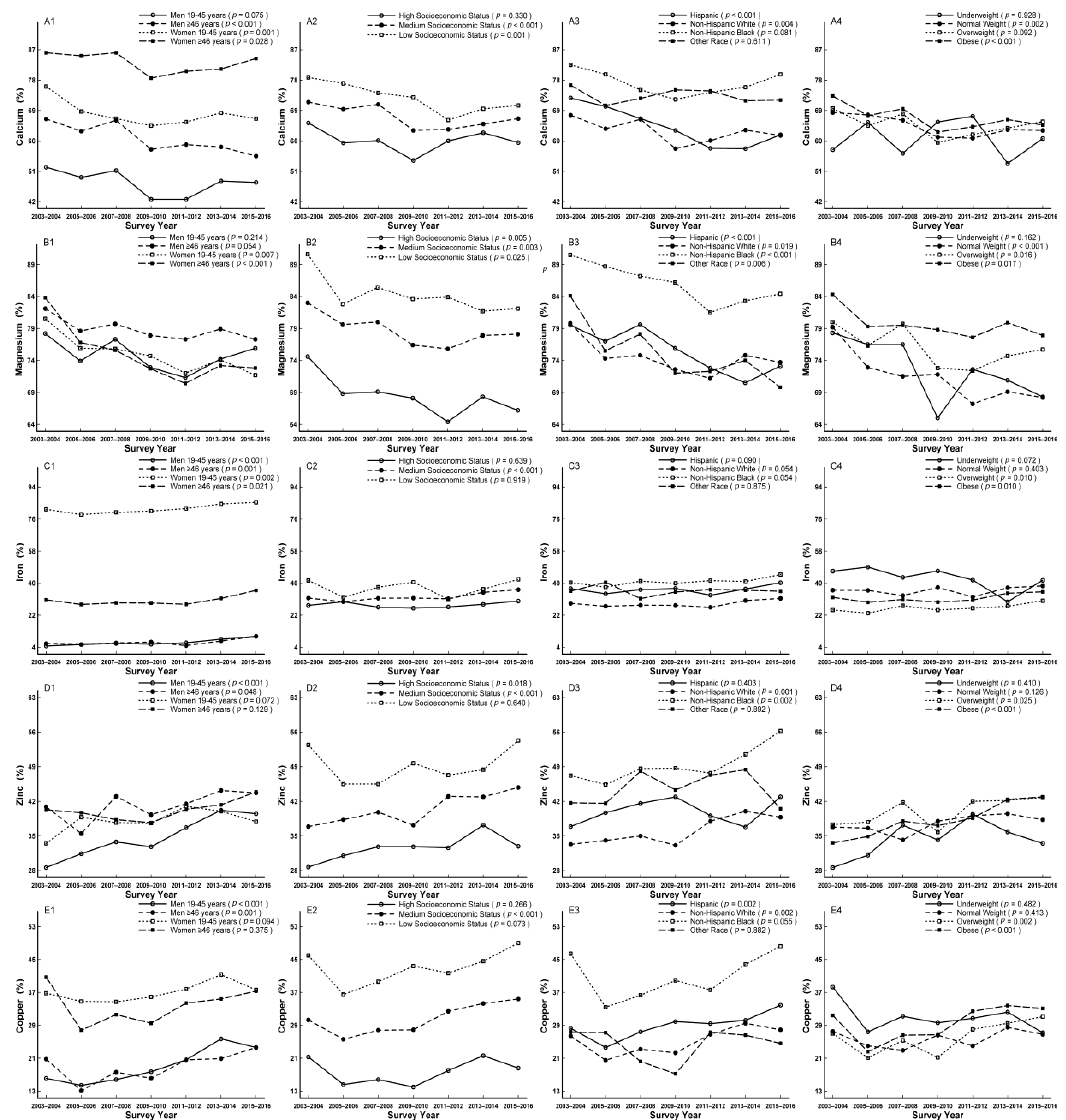
Figure 2. Trends of dietary calcium (A1–A4), magnesium (B1–B4), iron (C1–C4), zinc (D1–D4), and copper (E1-E4) by sex age, socioeconomic status, race/ethnicity, and body mass index (BMI) for